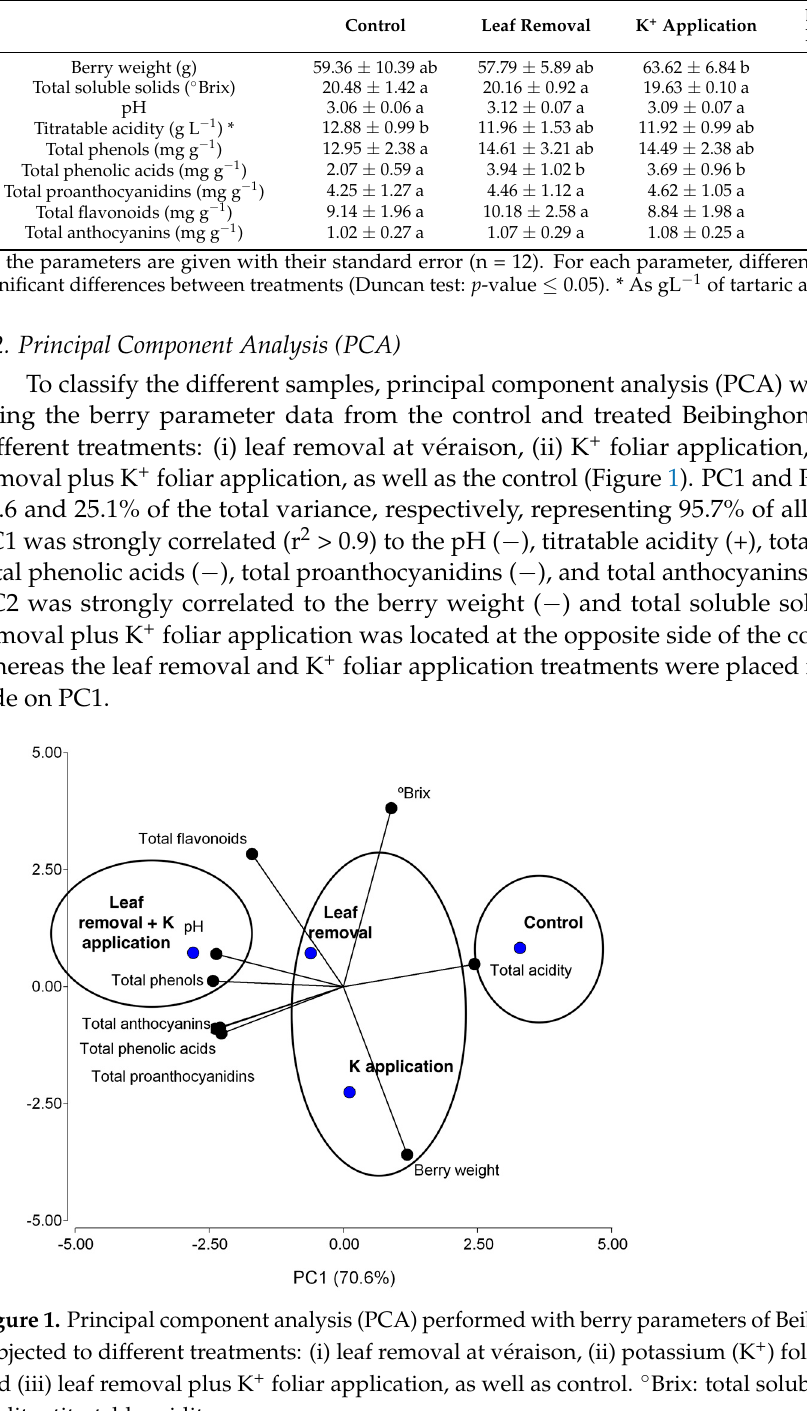
Table 1. Effects of leaf removal at v é raison, foliar potassium (K + ) foliar applications, and their combi- nation (leaf removal plus K + foliar applications) to vines on weight, physicochemical parameters, and phenolic compounds of Beibinghong berries. Control Leaf Removal K + Application